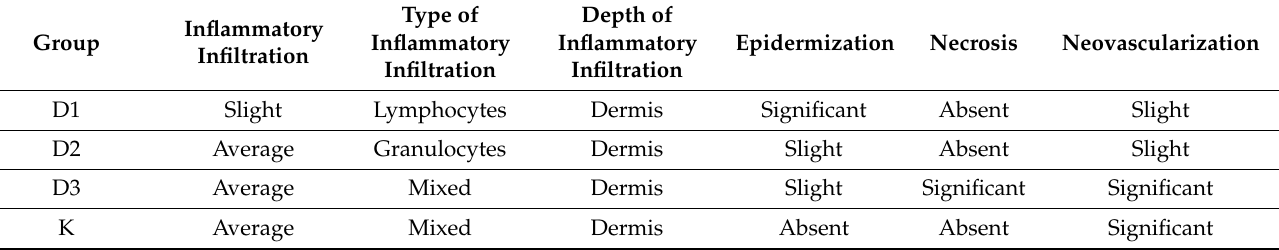
Table 11. Histopathological results from day 20.